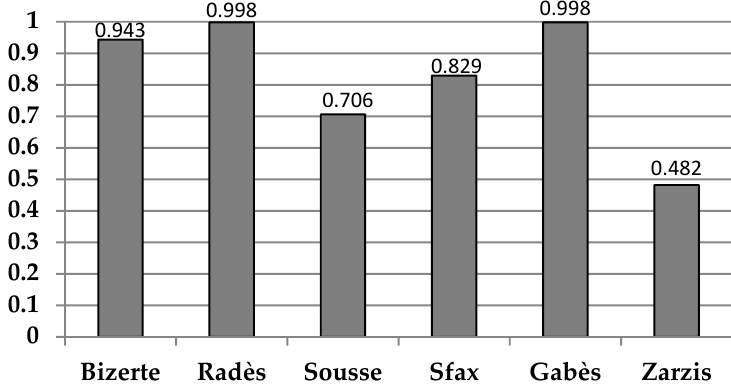
Figure 4. Scale efficiency of Tunisian ports (2005–2016).